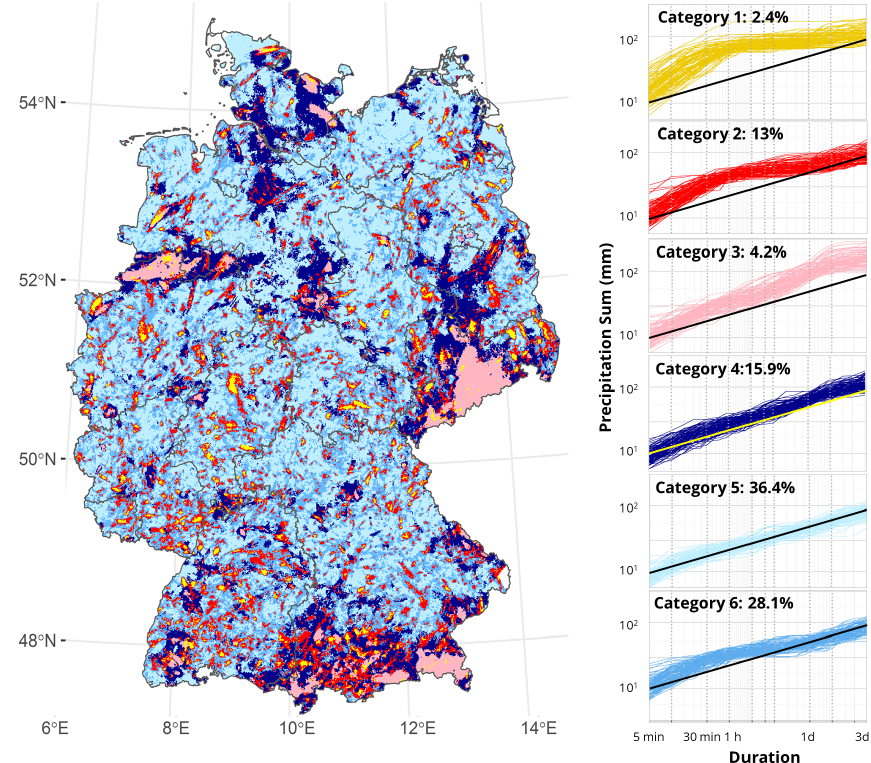
Figure 8. Resulting clusters of the maximum depth–duration relationships of rainfall for all pixels. The left panel shows the spatial distri- bution of the groups, distinguishable by colour. The corresponding curve shapes of 100 randomly selected radar pixels from each group are displayed on the right side with the same colours as the